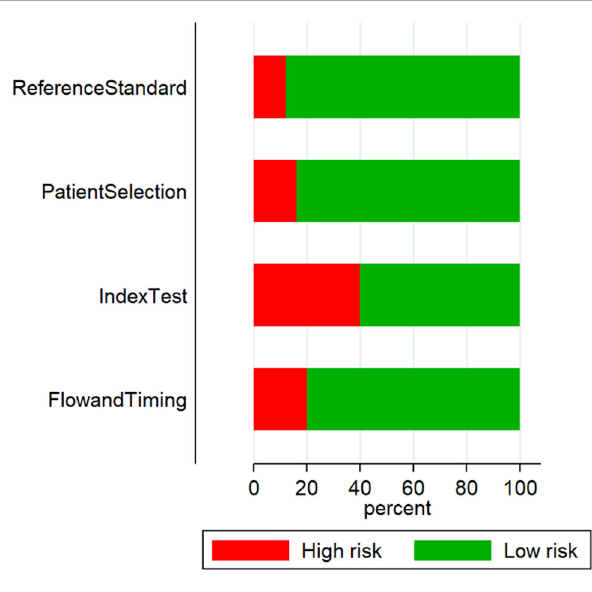
FIGURE 2 | Study quality assessment using the QUADAS-2 tool ( n =23).